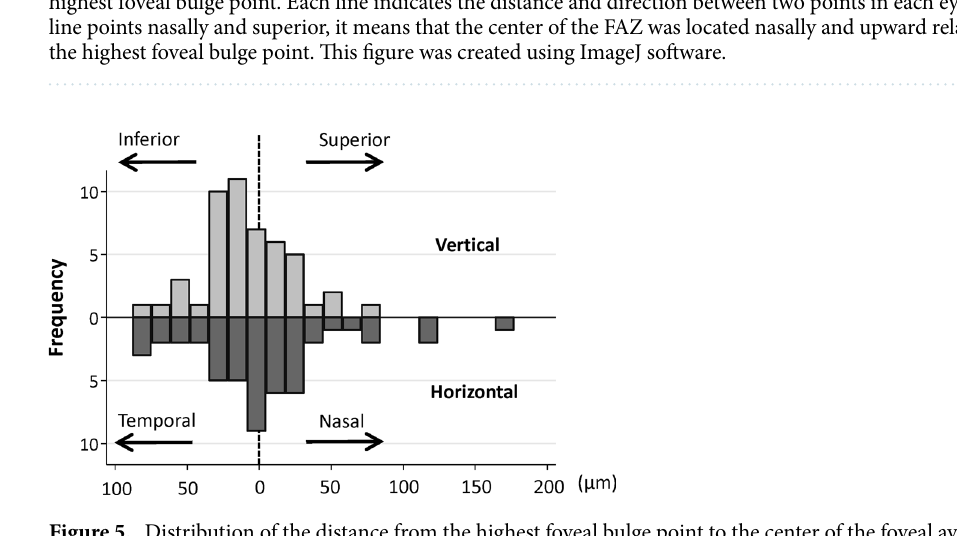
Figure 5. Distribution of the distance from the highest foveal bulge point to the center of the foveal avascular zone in the vertical and horizontal directions. Eye distribution of the distance from the highest foveal bulge (FB) point to the center of the foveal avascular zone (FAZ) in the vertical (top row) and horizontal (bottom row) directions. The peak distribution in the vertical direction is biased inferior. This means that many eyes had the center of the FAZ located inferior side than the highest FB point. This figure was created using Stata software version 15 (StataCorp LP, College Station, TX, USA).